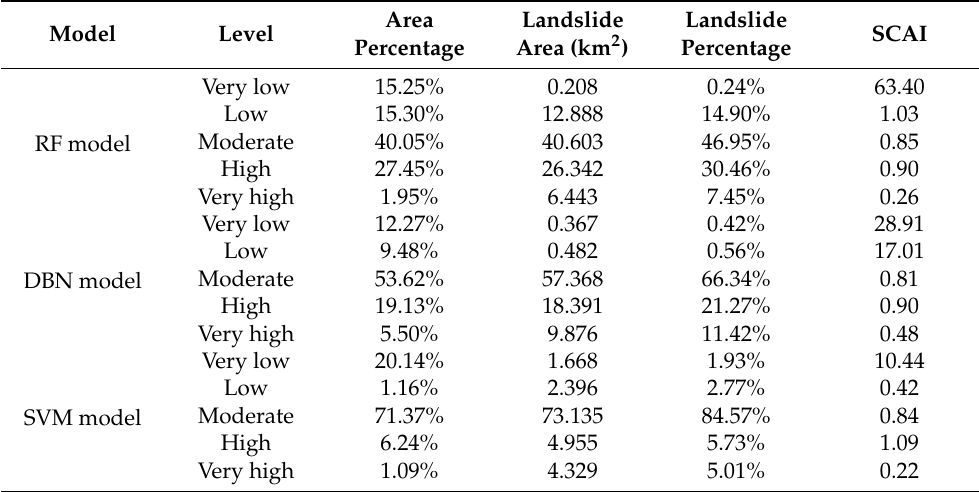
Table 4. Seed cell area indexes (SCAIs) of RF model, DBN model and SVM model.